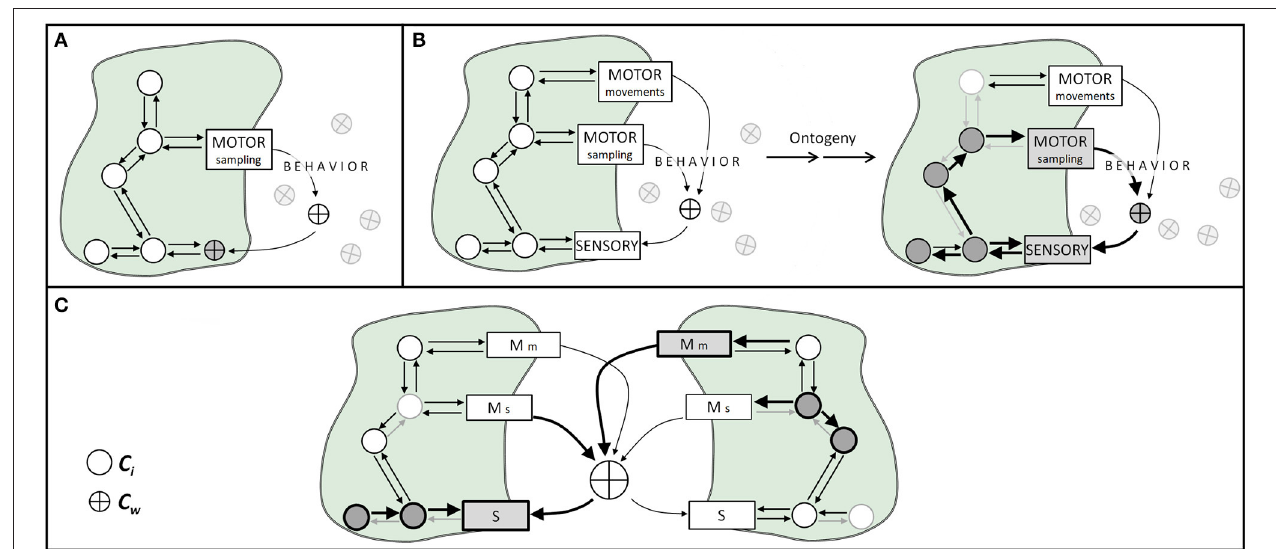
FIGURE 1 | Illustration of body-world coupling, sensorimotor mechanisms, and the ontogeny of social cognition. Circles represent mechanisms’ components internal to the organism ( C i ), and crossed circles depict world components ( C w ). Arrows represent causal effects between components. (A) In non-sensorimotor body-world couplings, an organism’s motor activities capture world’s components and makes them interact with body components. (B) In sensorimotor body-world couplings, through active motor sampling activities (e.g., sniffing, touching, fixating) the organism dynamically brings world components onto sensory surfaces. During ontogeny, the occurrence (or not) of specific sensorimotor activities produces plastic changes in body components, represented here as weighted arrows and circles. (C) Social cognition as a process grounded in sensorimotor coupling. World components relevant to sensorimotor coupling could well be stimuli produced by another organism, such as physical stimuli resulting from communication processes, and different agents coupled with shared world components can lead to social cognitive phenomena. This kind of sensorimotor coupling might entail different plastic processes within each organism (represented as different weighted arrows inside each agent). S, sensory; Mm, motor actions for movement; Ms, motor actions for